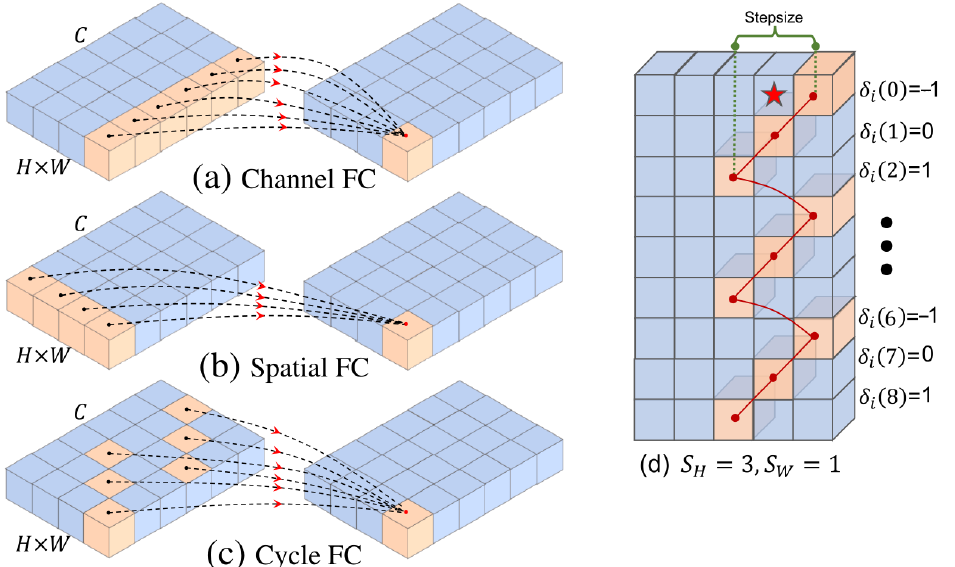
Figure 3. ( a ) Channel FC. ( b ) Spatial FC. ( c ) Cycle FC. ( d ) An example of Cycle FC. This image